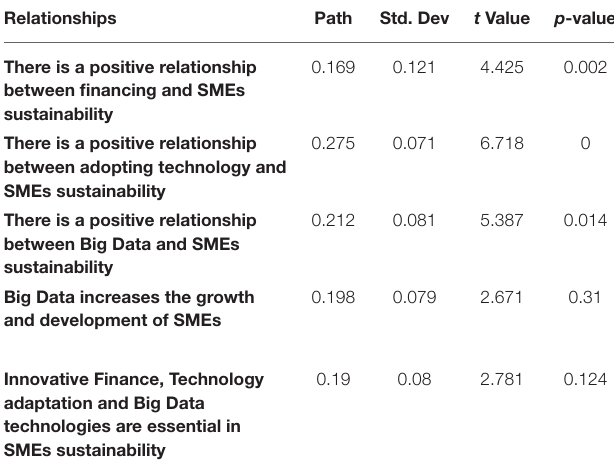
TABLE 5 | Results of hypothesis